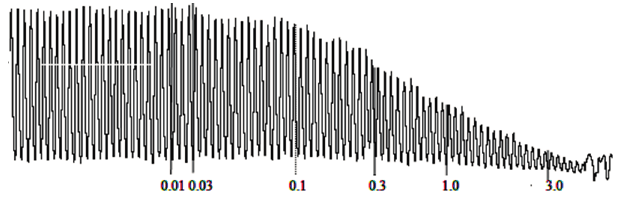
Figure 2. Effect of Skimmia laureola essential oil (mg/mL) on isolated rabbit